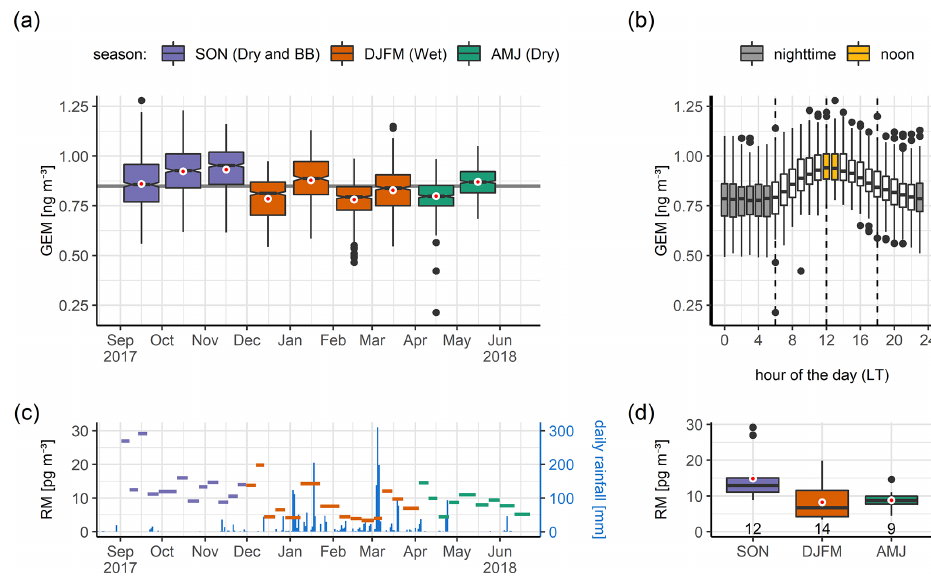
Figure 2. Overview of Hg observations. (a) Overview of 9 months of hourly GEM measurements at Maïdo. Red dots show arithmetic means. The notches show the 95% confidence interval for the median. The gray horizontal line gives the arithmetic mean of the whole dataset, which is nearly identical to the median (0.85ngm − 3 in both cases). (b) Diurnal GEM variation at Maïdo, characterized by a marked nighttime (23:00–05:59LT) minimum and a noon (12:00–13:59LT) peak. (c) Overview of RM measurements at Maïdo (a total of 35 weekly or biweekly samples). The length of each bar corresponds to the integration time of the respective RM observation. Total daily precipitation at Maïdo is given as blue bars (see the right axis). Around 82% of all precipitation during the 9-month measurement period fell between 1 December 2017 and 31 March 2018 (DJFM, corresponding to the wet season). (d) Seasonal variation in RM sampled at Maïdo. Red dots show arithmetic means. The numbers indicate the number of available RM samples for the respective